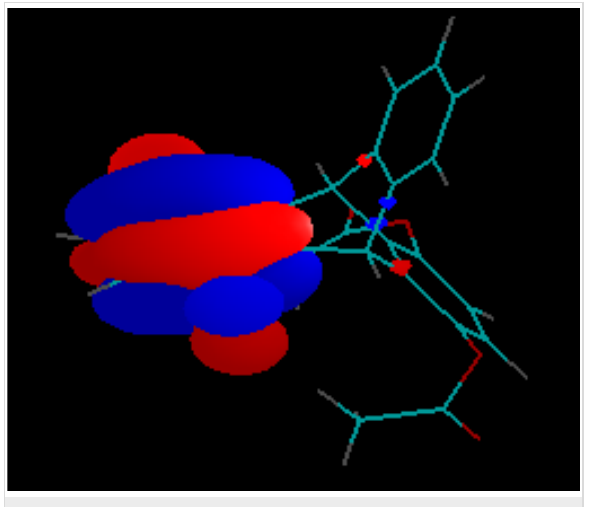
correlate with calculated LUMO+1 energies. As opposed to the LUMO orbitals, the LUMO+1 orbital coefficients are weighted significantly on the non-quinone part of the bicyclic system. This accounts for: (1) significantly larger substituent effect on the second redox-potentials, than on the first redox-potentials; (2) lack of stability of the product of two electron reduction of 5,8-diacetoxy-9,10-dihydro-9,10-[1,2]benzenoanthracene-1,4- dione 5